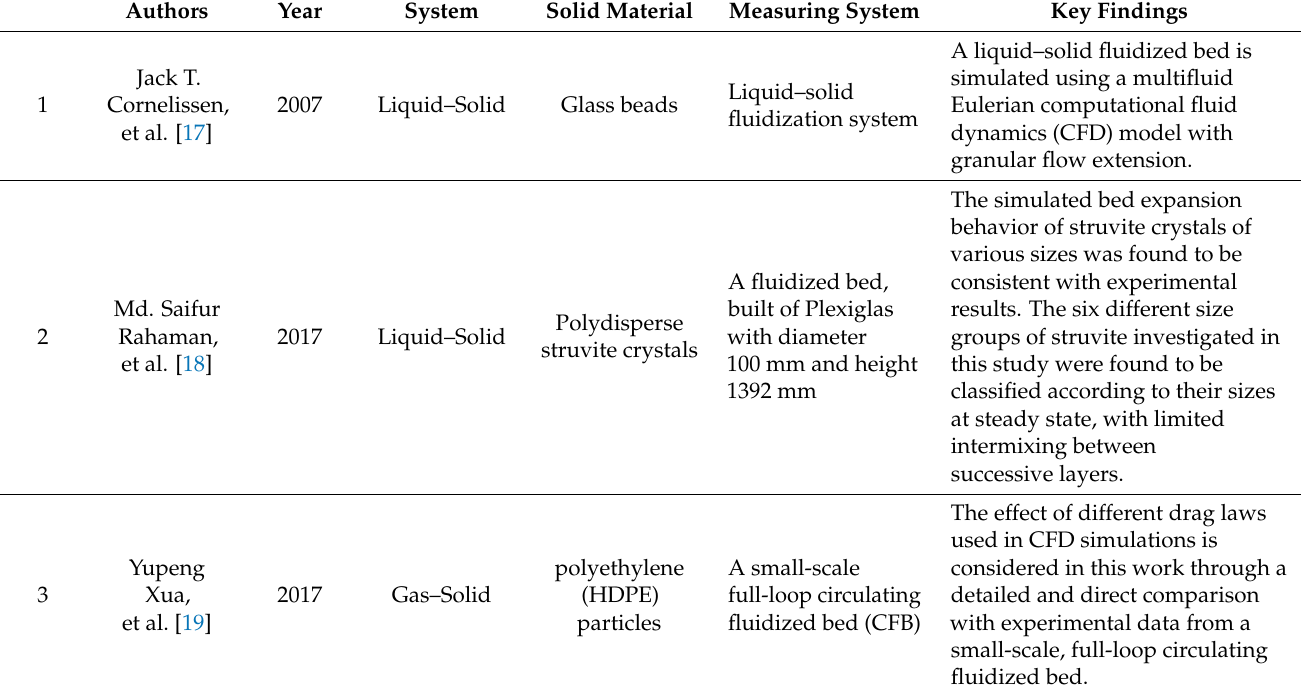
Table 1. Some of the sources of previous studies in a fluidized bed for experimental investigations and CFD